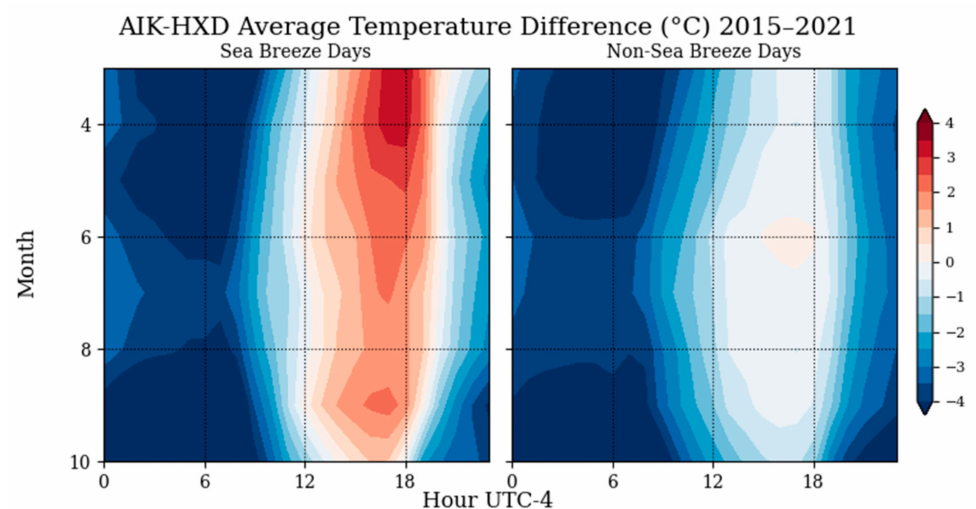
Figure 4. Differences in average hourly temperature between an inland (Aiken) and a coastal (Hilton Head Island) weather station.